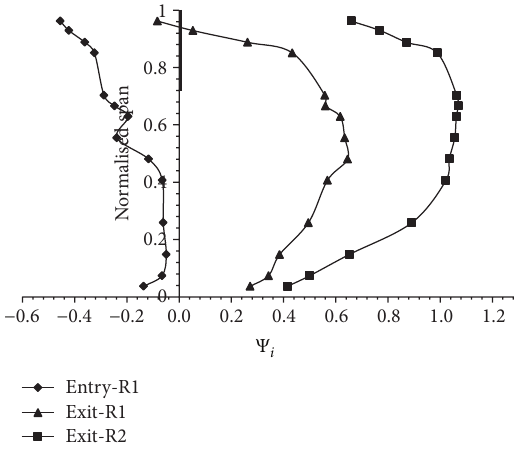
Figure 16: Spanwise total pressure coefficient along the stage at design speed